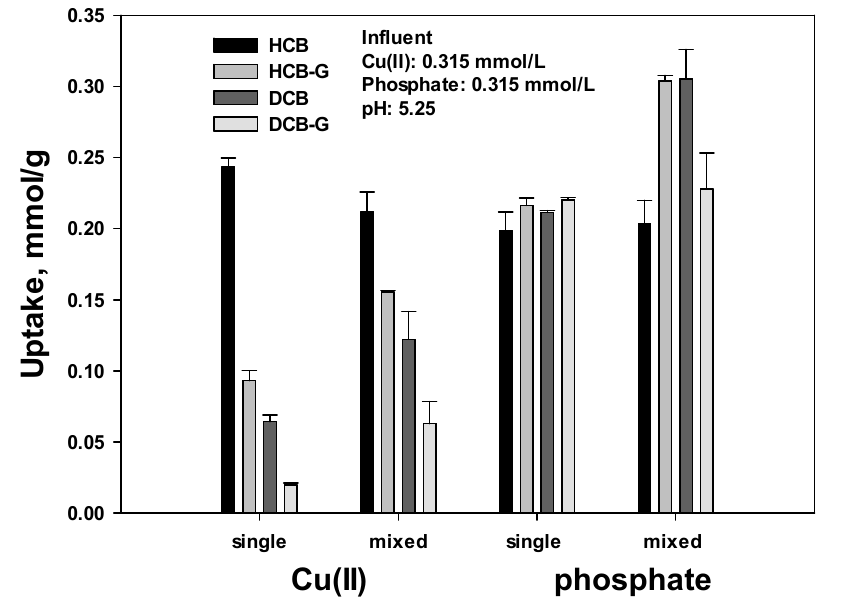
Figure 1. Cu(II) and phosphate uptake (mmol/g) using four types of chitosan beads (CB), namely hydrogel CB (HCB), glutaraldehyde-treated HCB (HCB-G), and the corresponding dried samples of DCB and DCB-G, under single and mixed conditions.